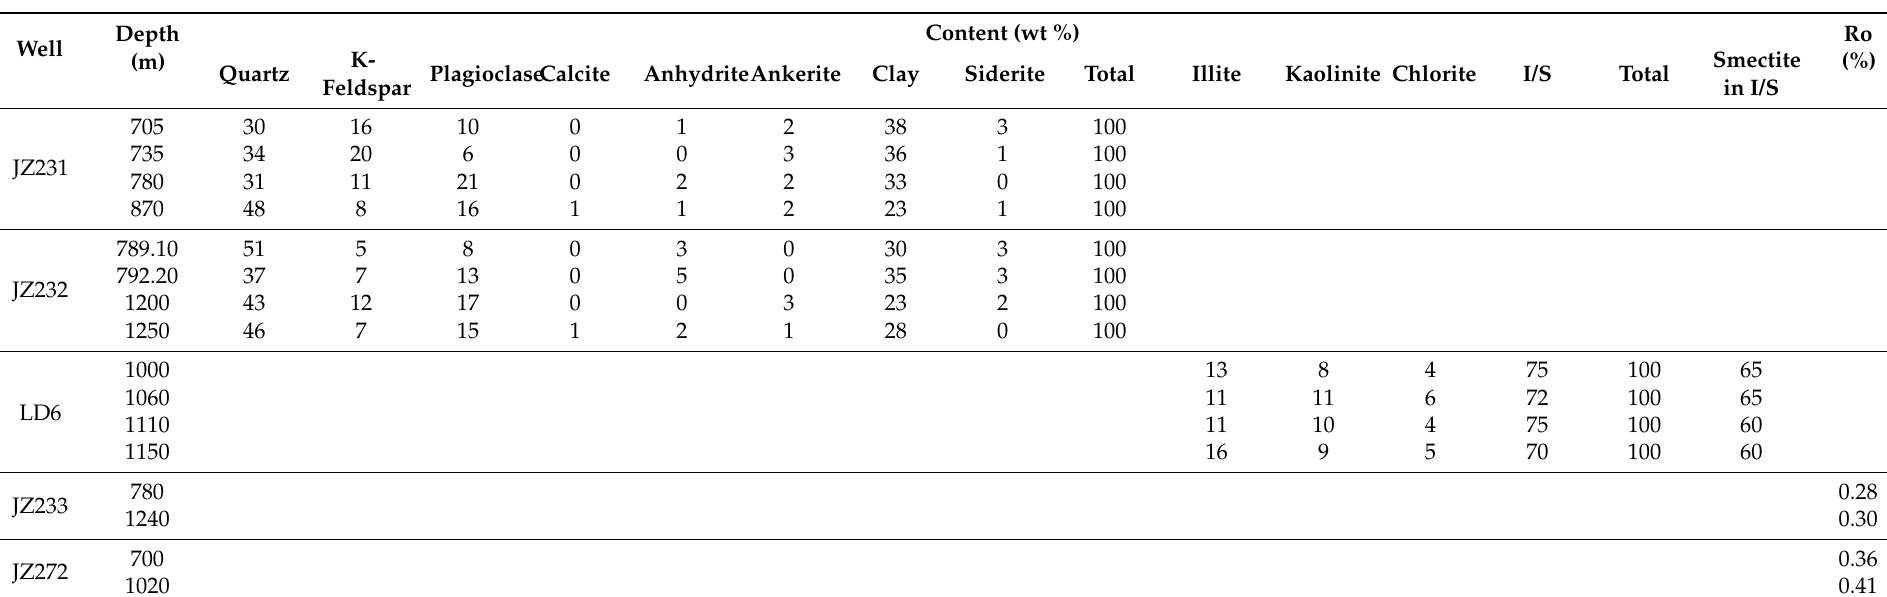
Table 1. XRD analysis data and vitrinite reflectance of mudstones of the Guantao Formation in the Liaodong sub-uplift.